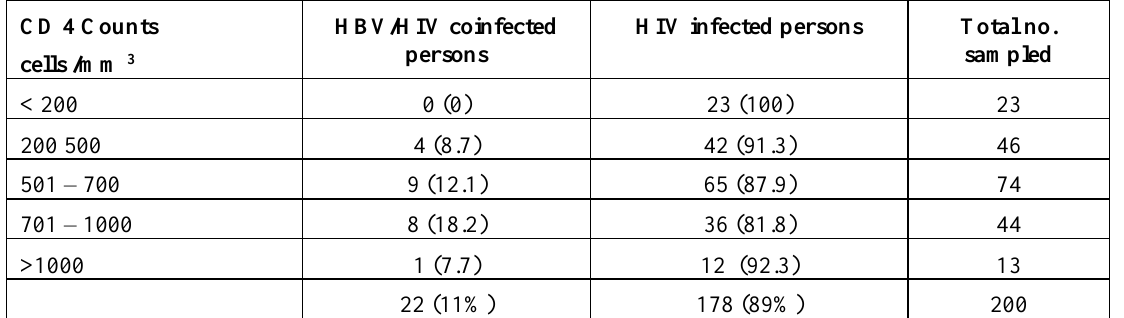
Table 4. Distribution of CD4 count in relation to HIV/HBV status